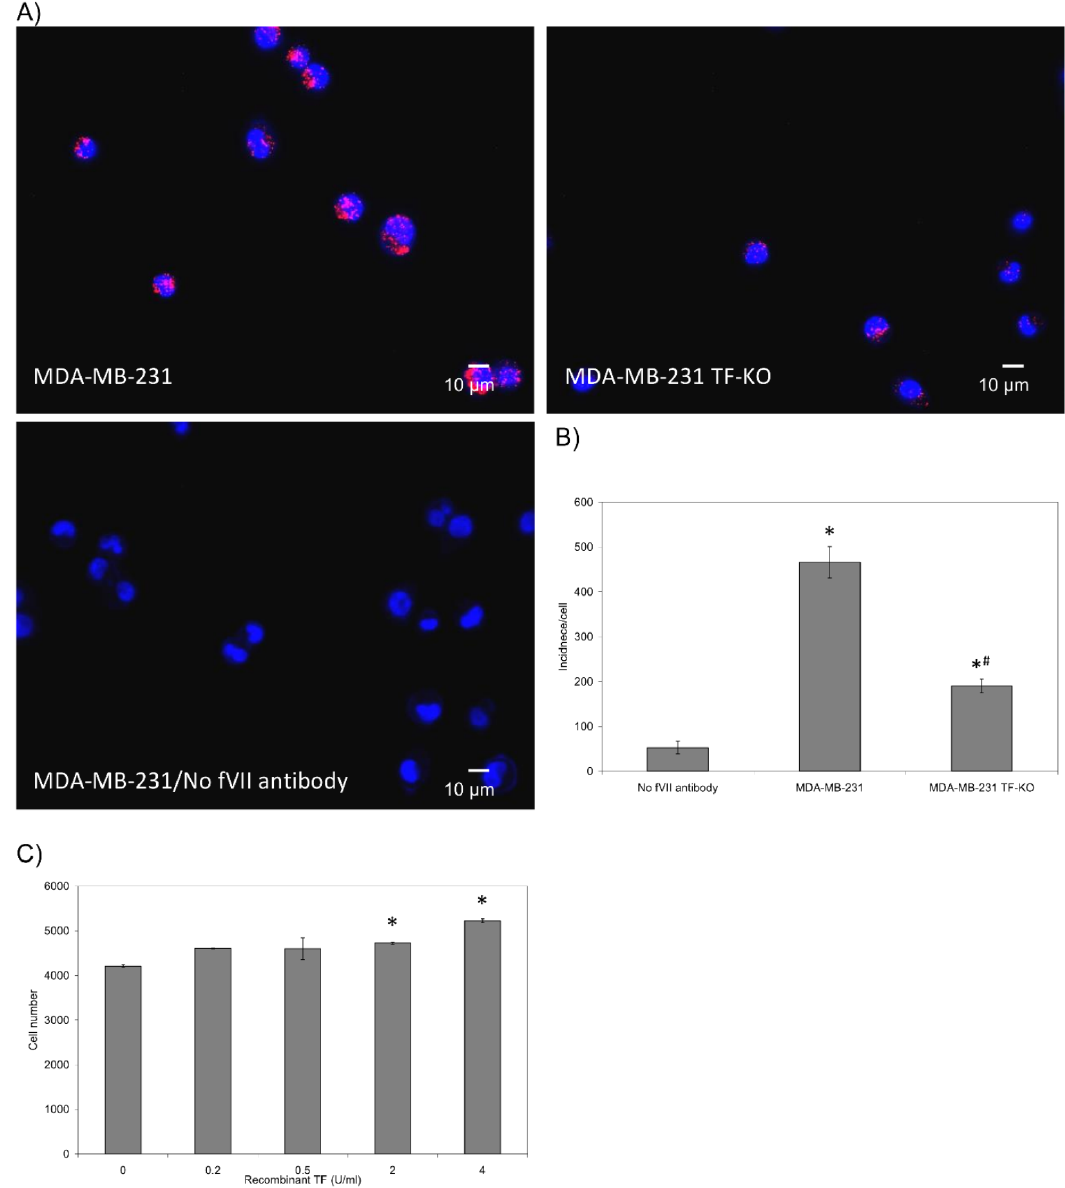
Figure 2. Analysis of the association of fVII and PAR2 in the presence and absence of TF: Wild-type MDA-MB-231 and MDA-MB-231 TF-KO cells (10 3 ) were seeded out into 35 mm-glass based µ -dishes overnight. Cells were then fixed with 4% ( v / v ) paraformaldehyde for 15 min, washed three times with PBS for 5 min and blocked with Duolink blocking buffer for 1 h. The cells were then incubated overnight at 4 ◦ C with a polyclonal rabbit anti-fVII antibody (10 µ g/mL) and a mouse anti-PAR2 antibody (SAM11; 20 µ g/mL). ( A ) The dishes were washed three times with PBS and PLA performed according to the manufacturer’s instructions. The cells were stained with DAPI (2 µ g/mL). Images were acquired using a Zeiss Axio Vert.A1 inverted fluorescence microscope with a 40 magnification. A different representative of the control samples in × which one primary antibody was substituted with a isotype control is presented in each of the figures. ( B ) The number of red fluorescent events and nuclei were determined as incidence/cell in 10 fields of view from each assay using the ImageJ program. ( n = 4; * = p < 0.05 vs. the control; # = p < 0.05 vs. Wild type MDA-MB-231 cells). ( C ) MDA-MB-231 TF-KO cells (2 10 3 ) cells were seeded out in 24 well plated and supplemented with a range of recombinant TF (0–4 U/mL). Cell × numbers were determined at 48 h, by crystal violet staining. ( n = 3; * = p < 0.05 vs. No TF